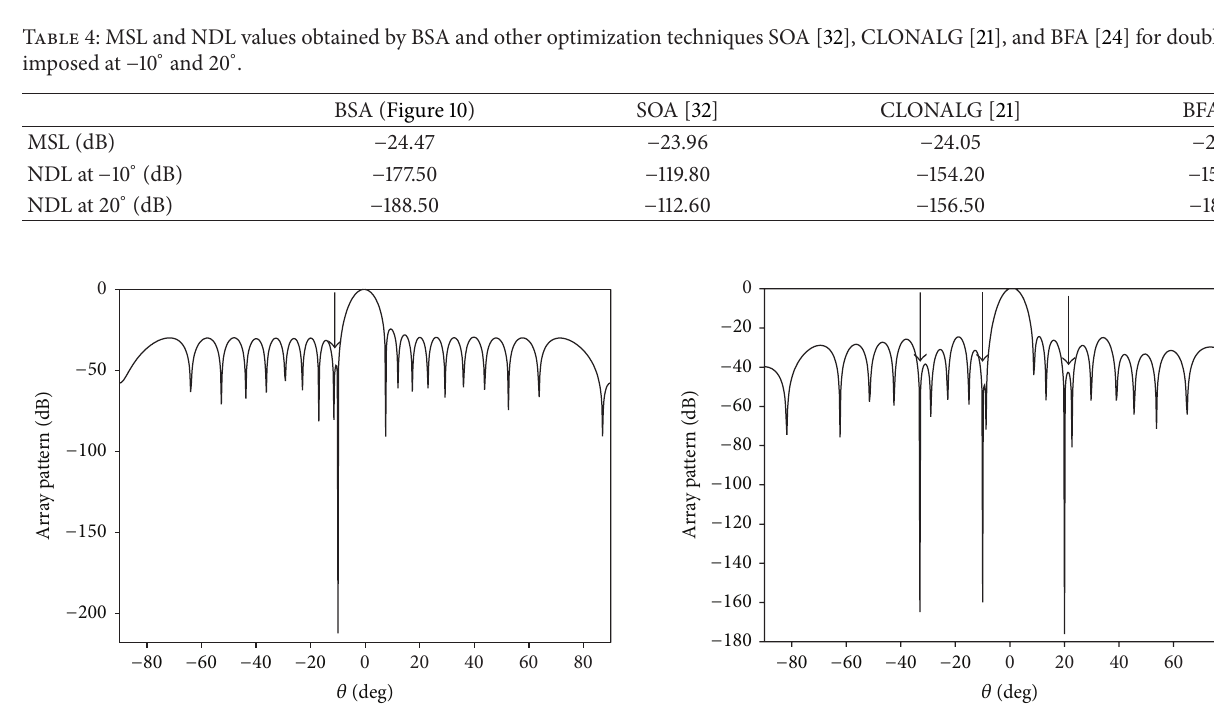
Figure 9: Radiation pattern found by phase only control with one null at − 10 ∘ .